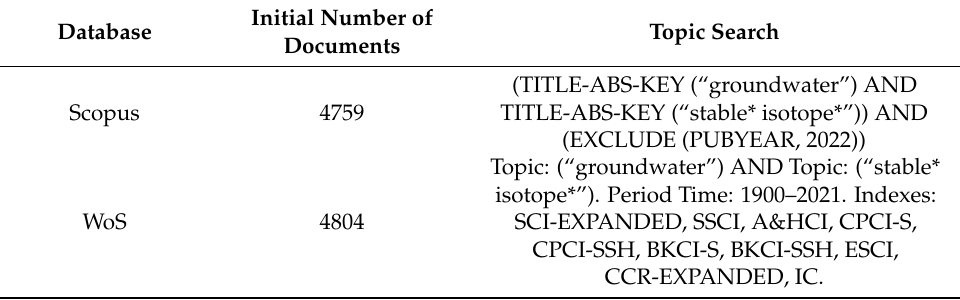
Table 1. Topic Search of